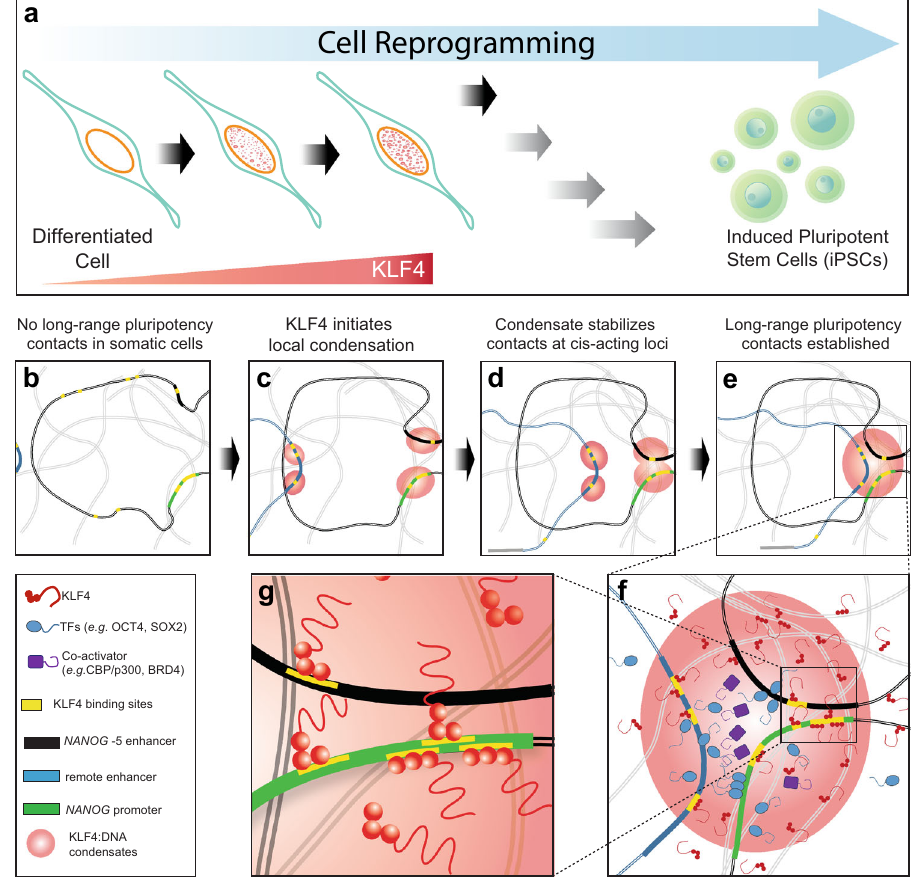
Fig. 7 KLF4:DNA condensation as an organizer of chromatin. a KLF4 levels rise early in reprogramming, leading to KLF4 biomolecular condensation. b – g Proposed roles for KLF4:DNA condensates in chromatin reorganization during reprogramming. b Pluripotency-related sites in closed chromatin of somatic cells lack KLF4. c Sites will recruit KLF4 and form local KLF4:DNA condensates as expression levels rise. d Random diffusive encounters of cis-acting elements leads to fusion of their condensates and persistent colocalization. e Loci on different chromosomes can also be co-localized in